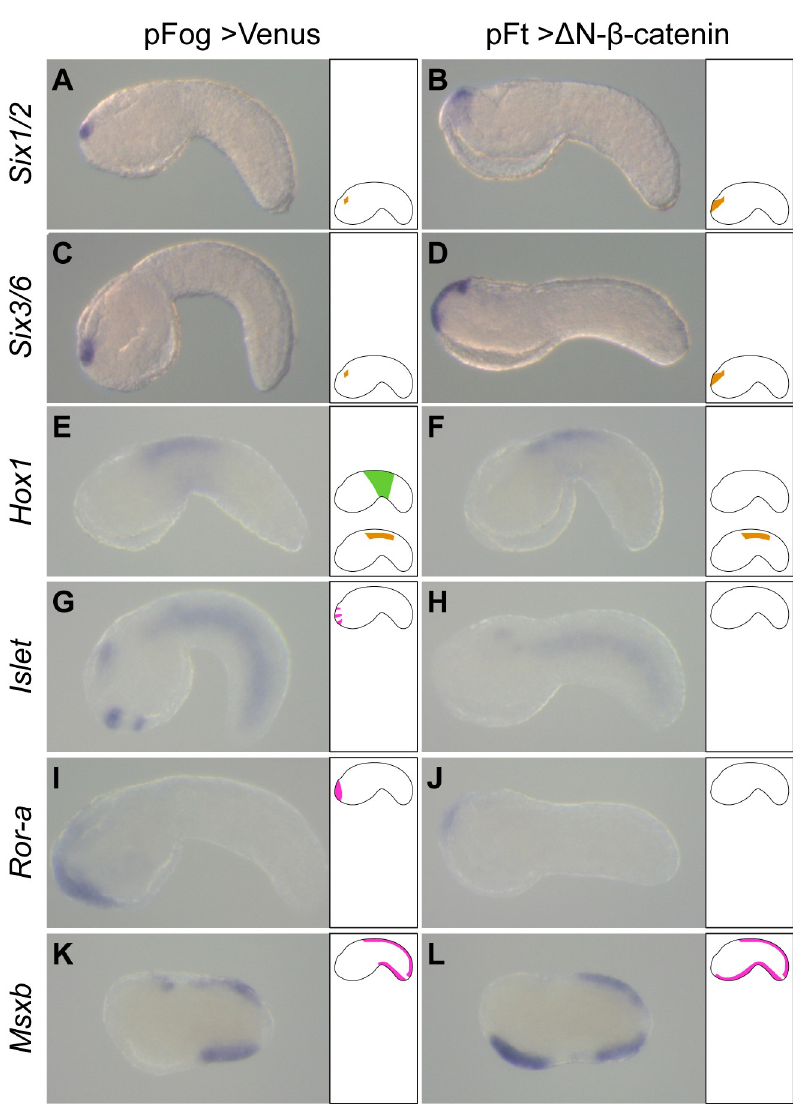
Fig 3. Activating cWnt by overexpression of Δ N- β -catenin phenocopies Gsk3 inhibitor treatment. Embryos were electroporated and fixed for in situ hybridization at initial tailbud stages (stage 18, K and L) and early tailbud stages (stage 21, A to J). Control pFog > Venus-electroporated embryos (A, C, E, G, I and K) and pFt > Δ N- β -catenin- electroporated embryos (B, D, F, H, J and L). Following Δ N- β -catenin overexpression, note the anterior extension of Six1/2 (B) and Six3/6 (D), the repression of epidermal expression of Hox1 (F), the repression of Islet (H) and Ror-a (J) in the palp forming region, and the ectopic expression of Msxb (L) in the ventral trunk epidermis. Embryos are oriented with dorsal to the top and anterior to the left. On the right side of each picture, a schematic embryo depicts our interpretation of the expression pattern according to each tissue: PNS (pink at the top), epidermis (green in the middle) and CNS (orange at the bottom). Number of experiments: one for Hox1 , Islet and Ror-a ; two for Six1/2 , Six3/6 and Msxb .